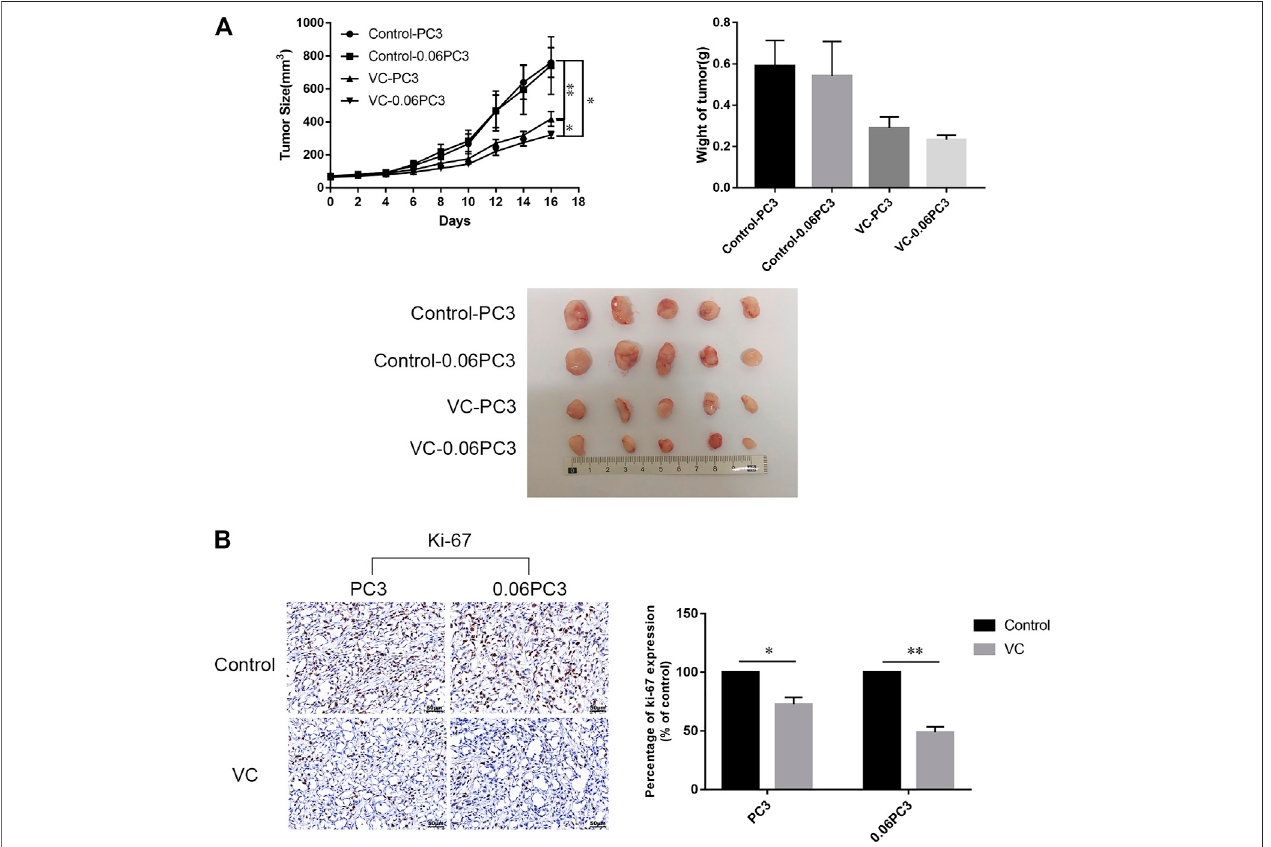
FIGURE 6 | Xenografts of cells overexpressing GS show slow tumor growth under VC treatment. BALB/c nude mice (4 – 5 weeks old/male) were subcutaneously (s.c.) injected with 2 × 10 6 PC3 cells. When the tumor sizes reached 50 – 80 mm 3 , ascorbate sodium (4 g/kg, twice a day) were intraperitoneally (i.p.) administered to the mice. After 16 days, all mice were euthanized and the tumors were analyzed. (A) Tumor volume and weight changed after treatment with VC. (B) Immunohistochemical analysesshowedtheexpressionofKi-67(proliferationmarker)decreasedintheVCtreatmentgroups,withmoreobviouschangeinthe0.06PC3group.Alldataare presented as means ± SEM, * p < 0.05, ** p < 0.01, n (cid:2) 3. VC, Vitamin